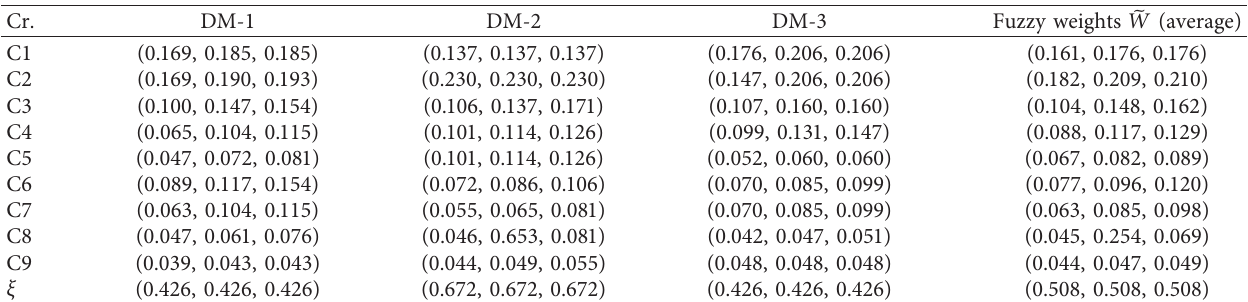
Table 9: Fuzzy weights of 9 criteria and related consistency indicator ( ξ ) for each decision-maker and average fuzzy weights. Cr.